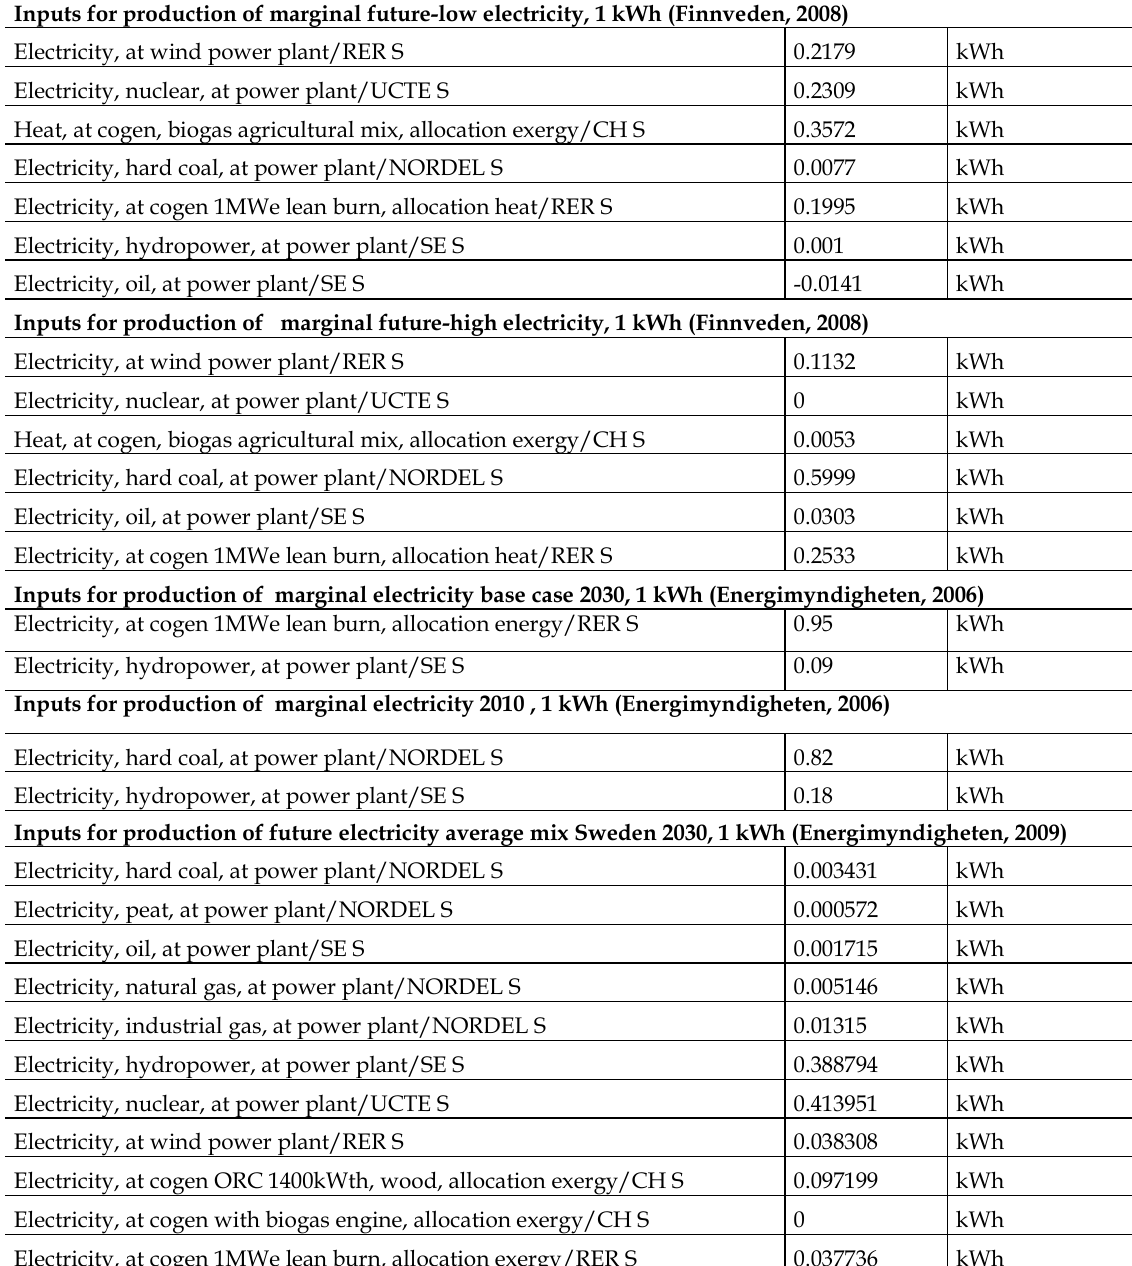
Table C-1 Modelling of electricity